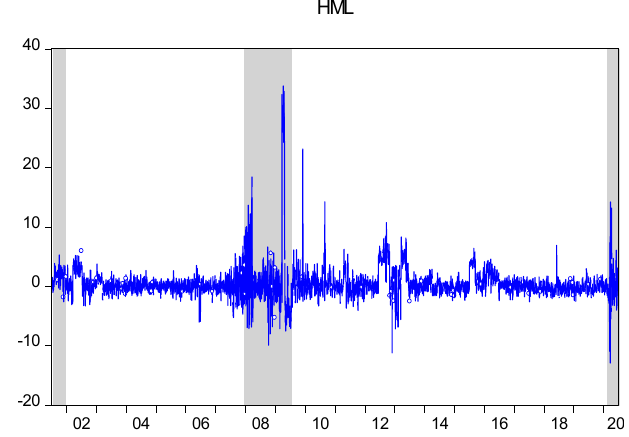
Figure 2. Time series variation in HML premiums.